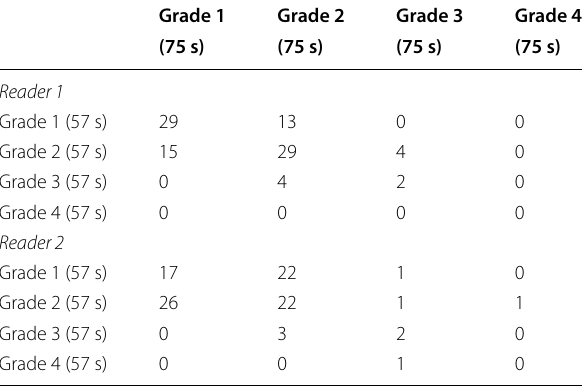
Table 5 Two crosstabs of image quality: grading of the 75 s